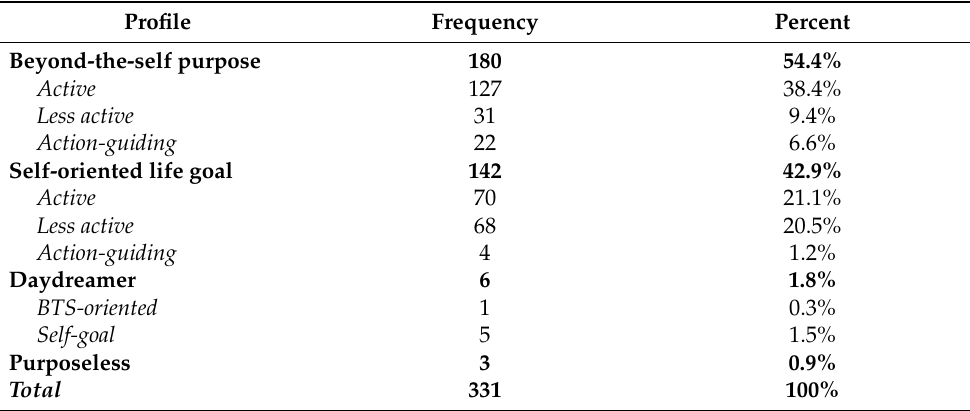
Table 2. Occurrence of qualitative purpose